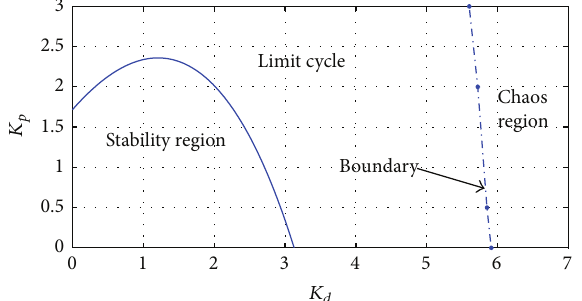
Figure 11: Bifurcation diagram of 𝜔 with 𝐾 𝑝 = 2 , 𝐾 𝑖 = 1 .